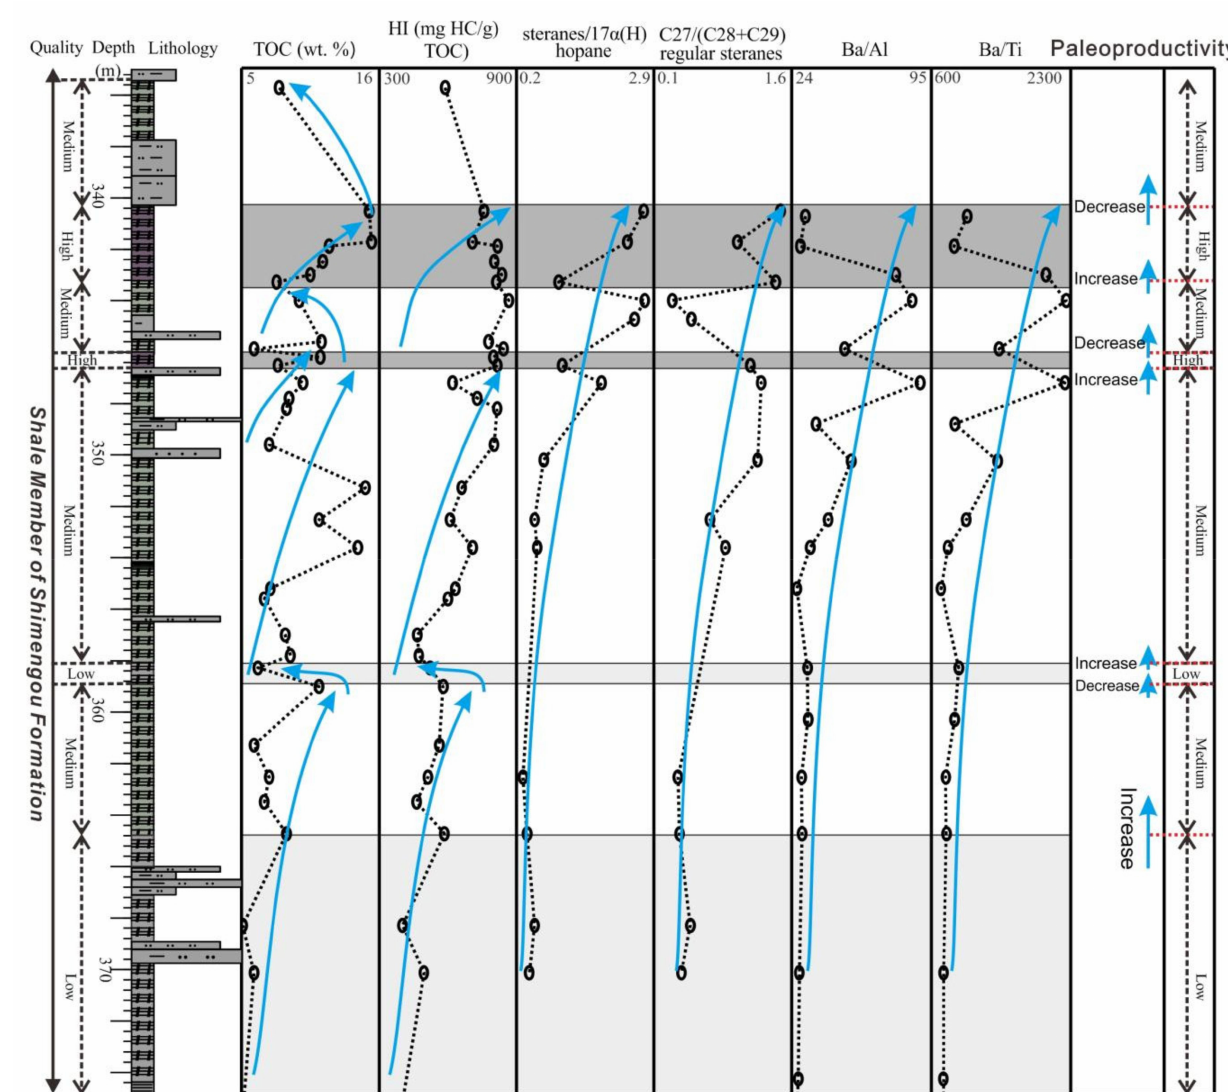
Figure 8. Vertical distribution of paleoproductivity in different-quality oil shales in the Shale Member of the Shimengou Formation (See Figure 2 for a legend; see Table 4 for ratio